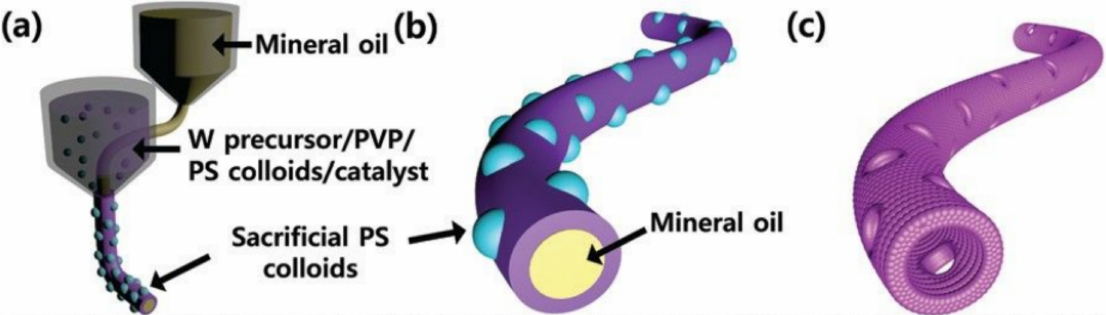
Figure 12. ( a – c ) Schematic illustrations of coaxial electrospinning using mineral oil in the core and composite solution in the shell. Reprinted with permission from [182]. Copyright 2016 Royal Society of